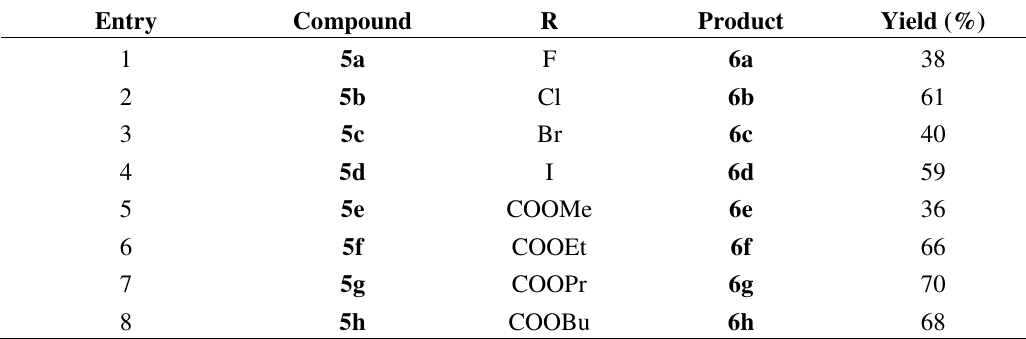
Table 1. Substrate scope of reduction of BISBOAs. Entry Compound R Product Yield (%)